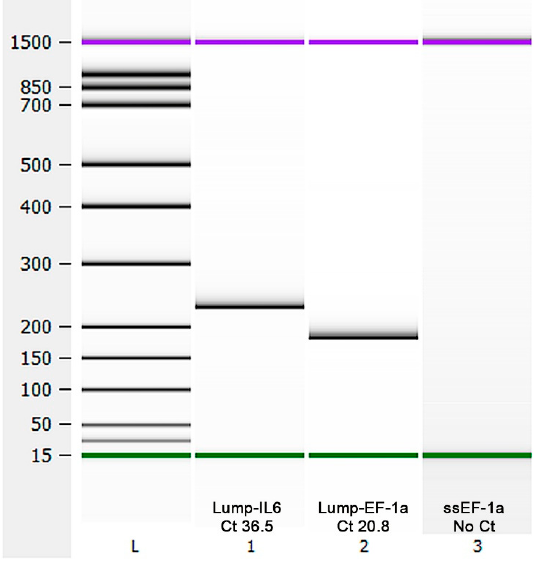
Figure 2. Control of lumpfish origin. The origin of the LG-1 cells was controlled by RT-qPCR on